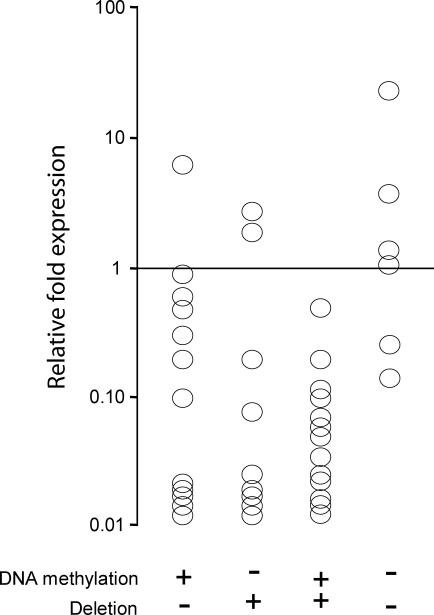

OLIG1 mRNA Expression in Primary Tumor Samples in Relation to OLIG1 DNA Methylation Levels and Deletions at the OLIG1 LocusEach circle represents a single sample. The presence of DNA methylation and/or deletions is indicated at the bottom of each sample column. mRNA expression levels are indicated in relation to normal lung, which was arbitrarily set as 1.